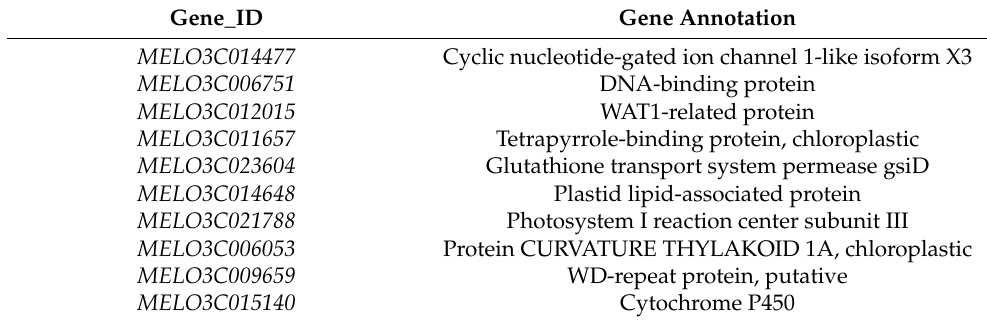
Table 2. The gene annotation of 10 hub genes.